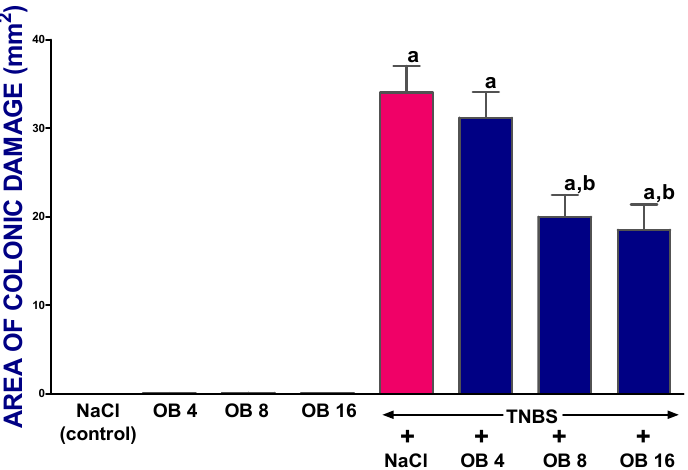
Figure 1. Effect of saline (NaCl) or obestatin given at doses of 4 nmol/kg (OB4), 8 nmol/kg (OB8), or 16 nmol/kg (OB16), and induction of trinitrobenzene sulfonic acid (TNBS)-induced colitis on the area of colon mucosal damage. Mean ± standard error of the mean (SEM). n = 10 in each group of animals. a p < 0.05 when compared with control; b p < 0.05 when compared with colitis + NaCl.